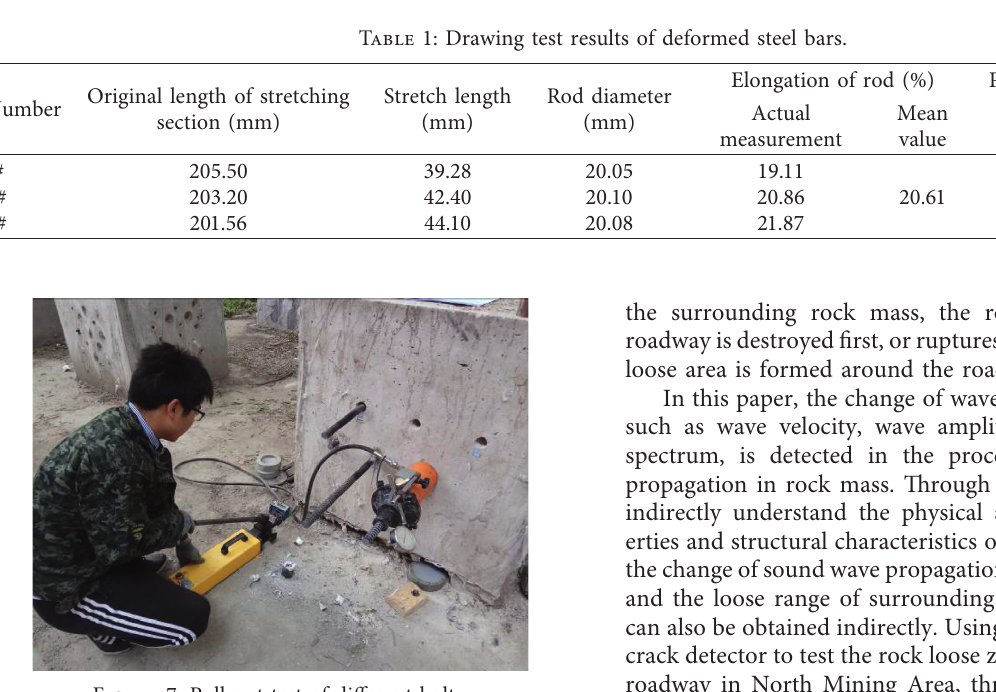
Figure 7: Pull-out test of different